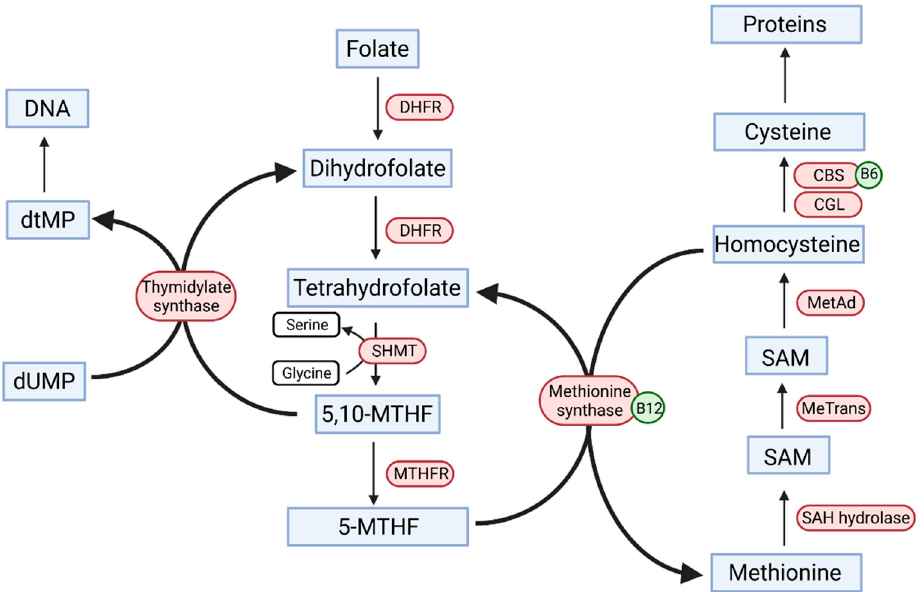
Figure 1. Folic acid cycle and homocysteine metabolism. DNA, deoxyribonucleic acid; dTMP, de- oxythymidine monophosphate; dUMP, deoxyuridine monophosphate; DHFR, dihydrofolate reduc- tase; SHMT, serine hydroxymethyltransferase; 5,10-MTHF, 5,10-methylenetetrahydrofolate;